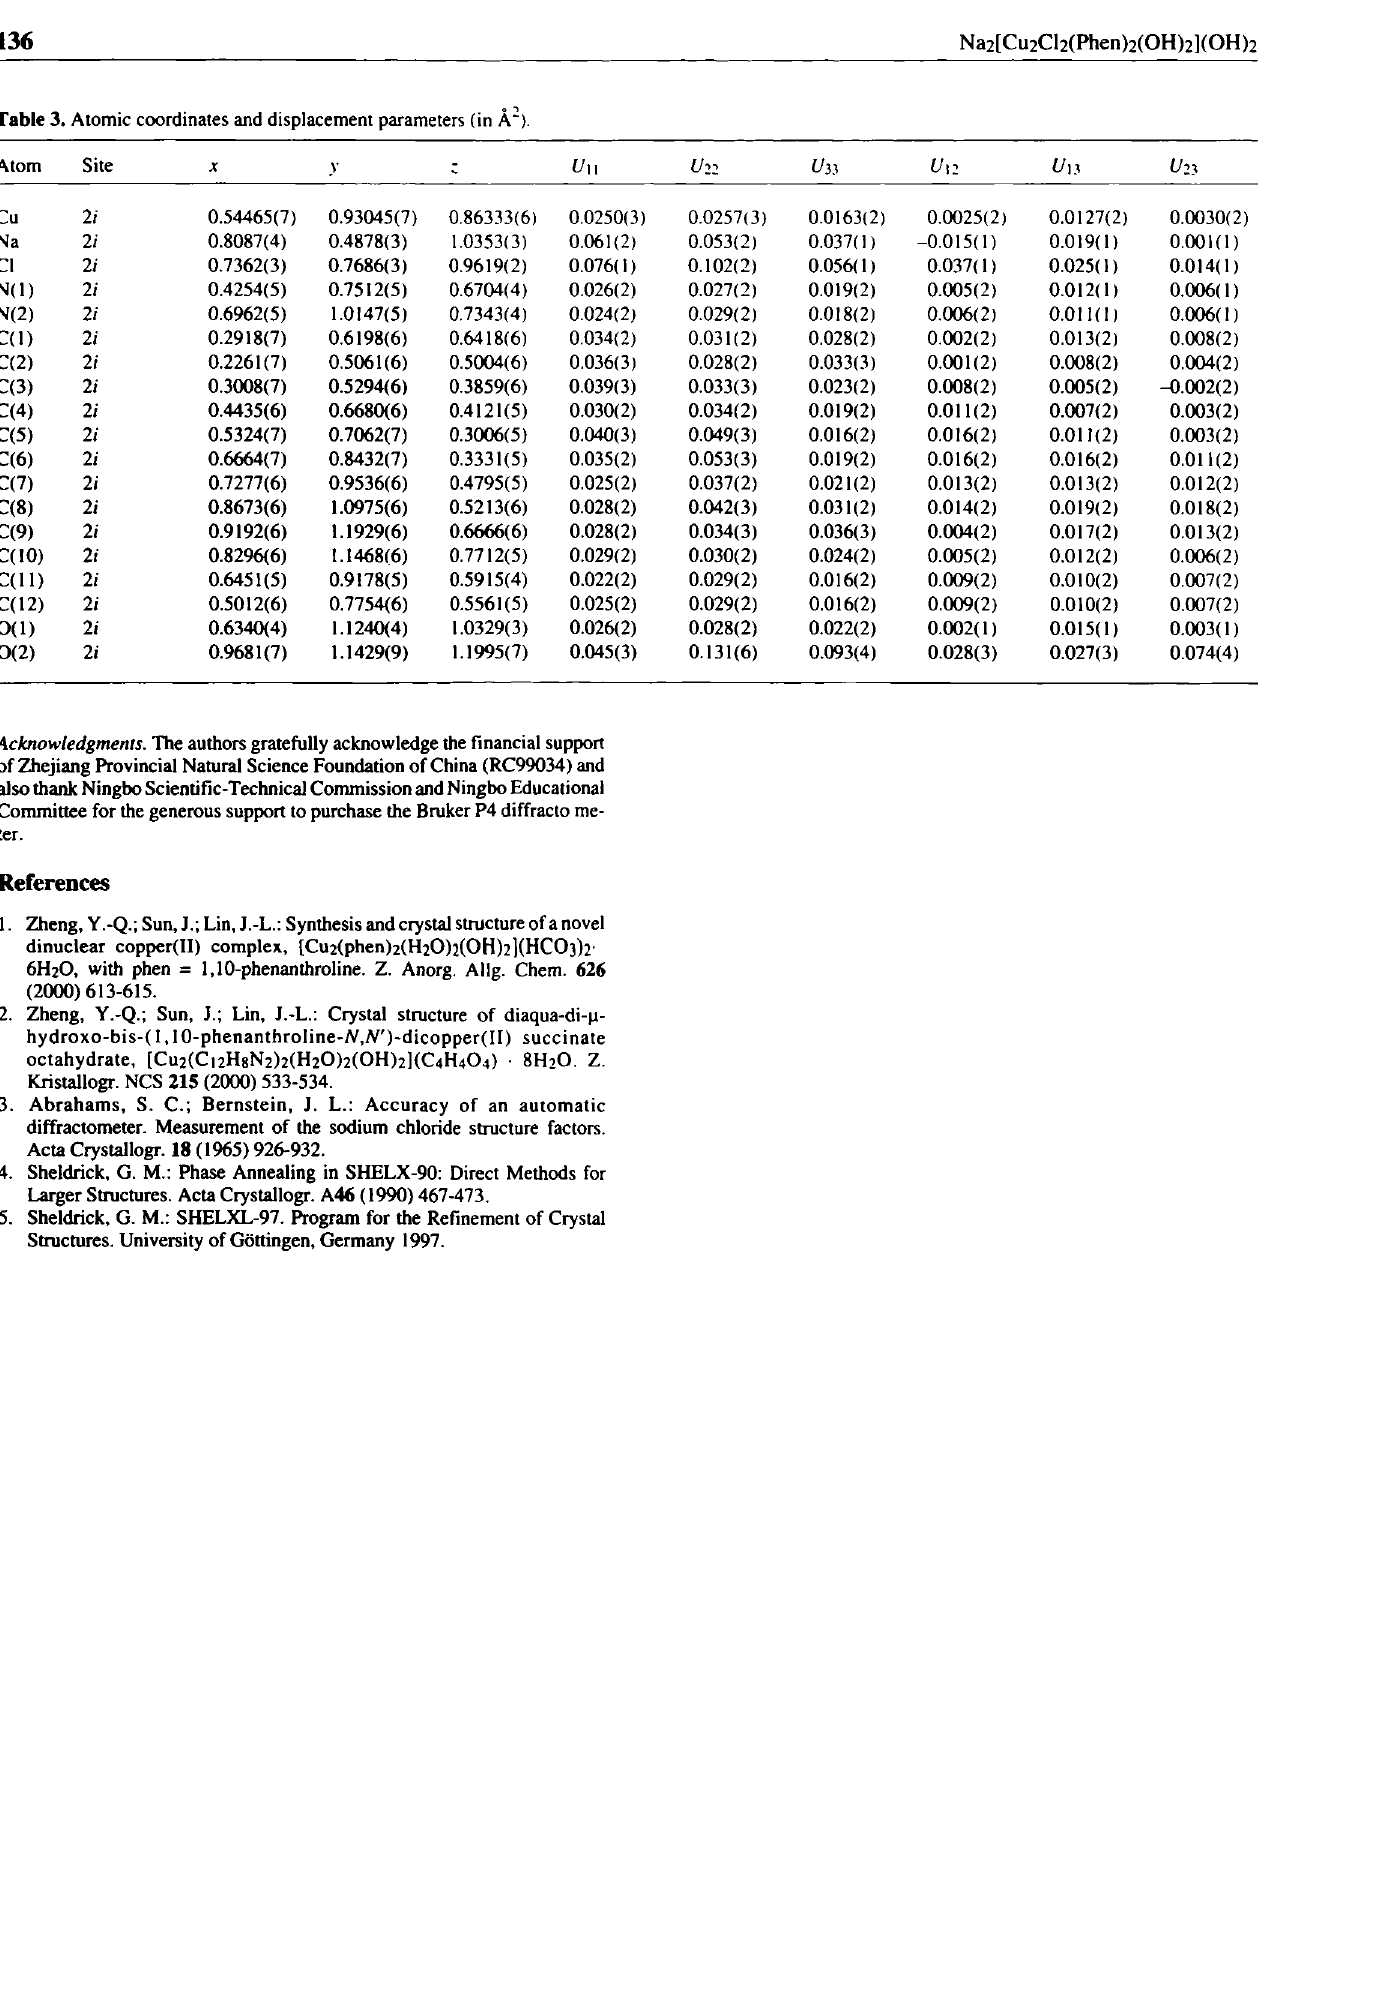
Table 3. Atomic coordinates and displacement parameters (in